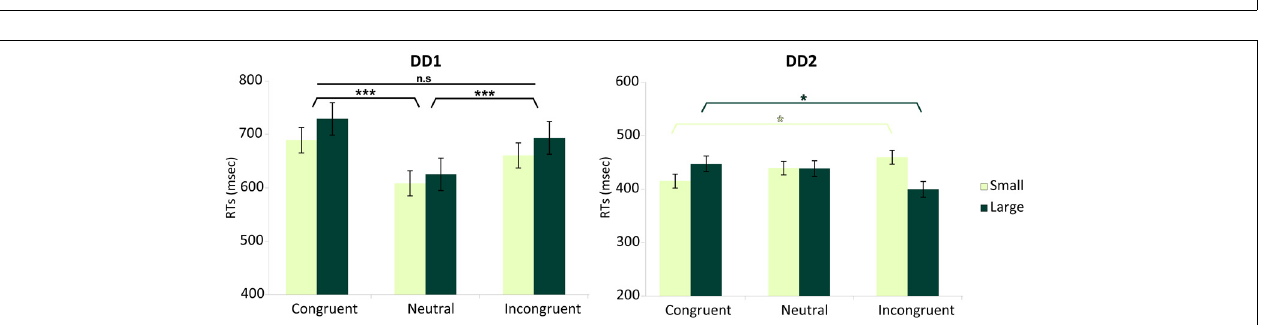
Congruent ( p < 0 . 05); Congruent vs. Incongruent ( p = 0 . 13); Incongruent vs. Neutral ( p = 0 . 08). For DD2: Congruent > Incongruent ( p < 0 . 05); Congruent vs. Neutral ( p = 0 . 07); Incongruent vs. Neutral ( p = 0 . 16). Data are mean ± standard error (SE) of the mean. ∗ p < 0 . 05.